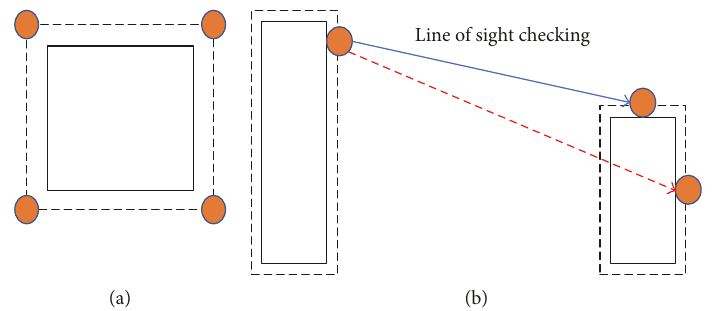
Figure 3: Visualization of steps in roadmap-creation algorithm: (a) extension of distance; (b) line of sight checking between